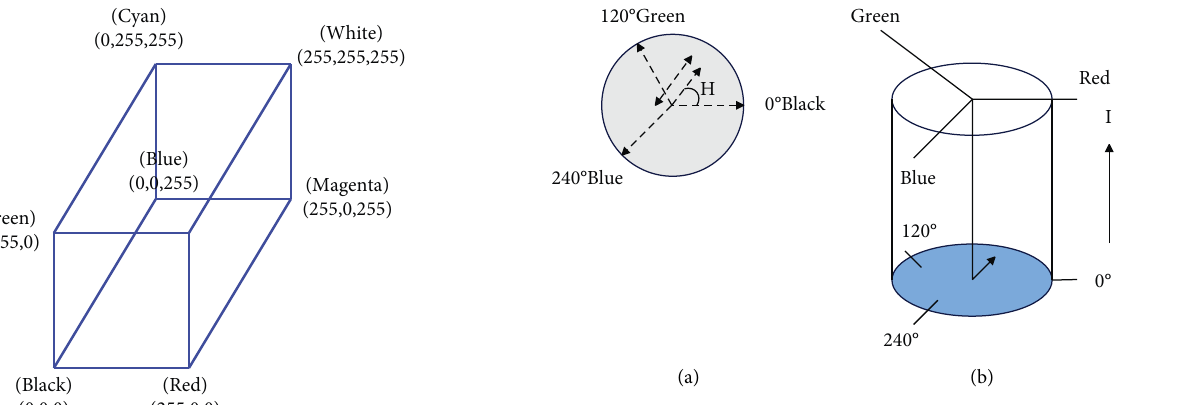
Figure 2: HSI colour model. (a) Color cycle and (b) Column color